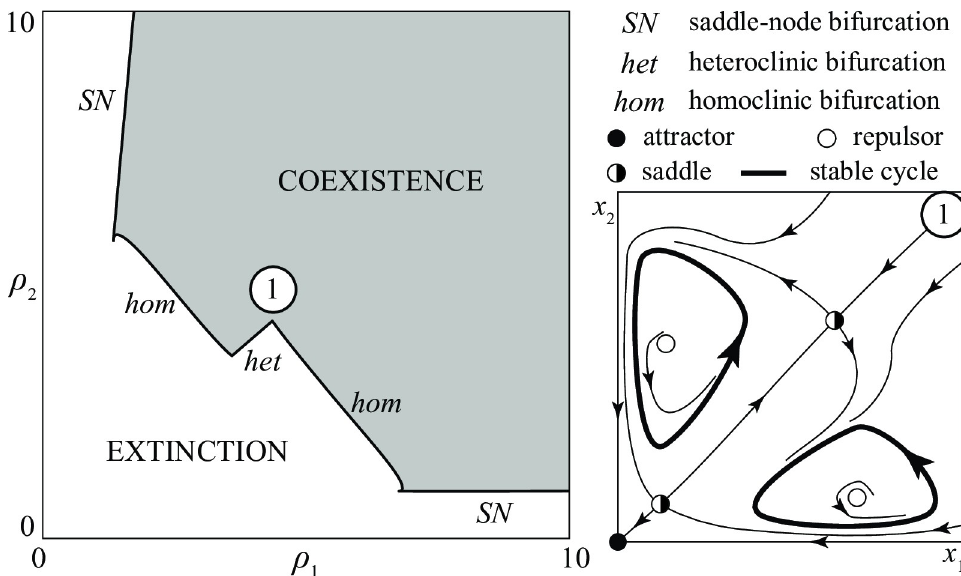
Fig 12. Example of a bifurcation diagram of a A—A